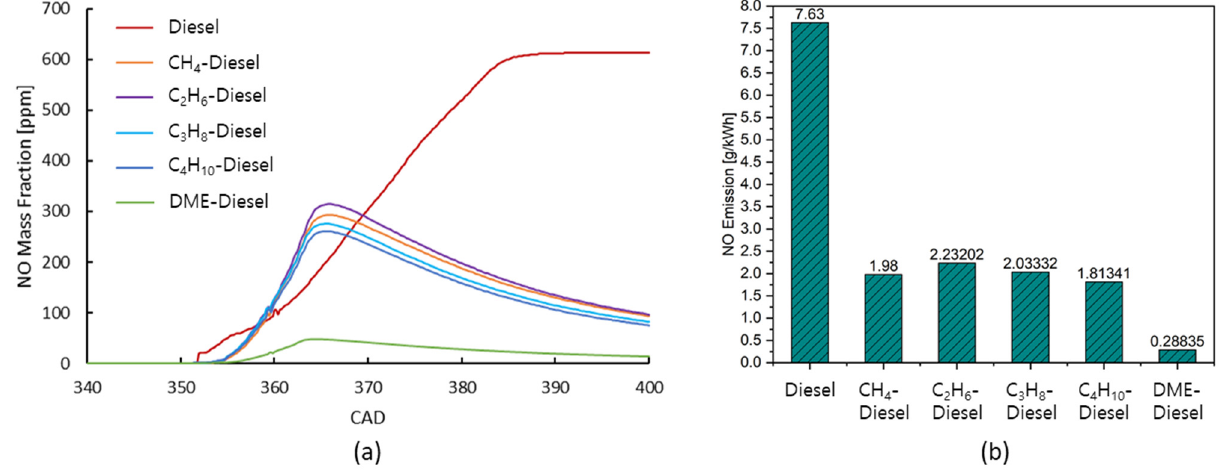
Figure 13. Mean NO mass fractions ( a ) and NO emission masses ( b ) in all combustion cases